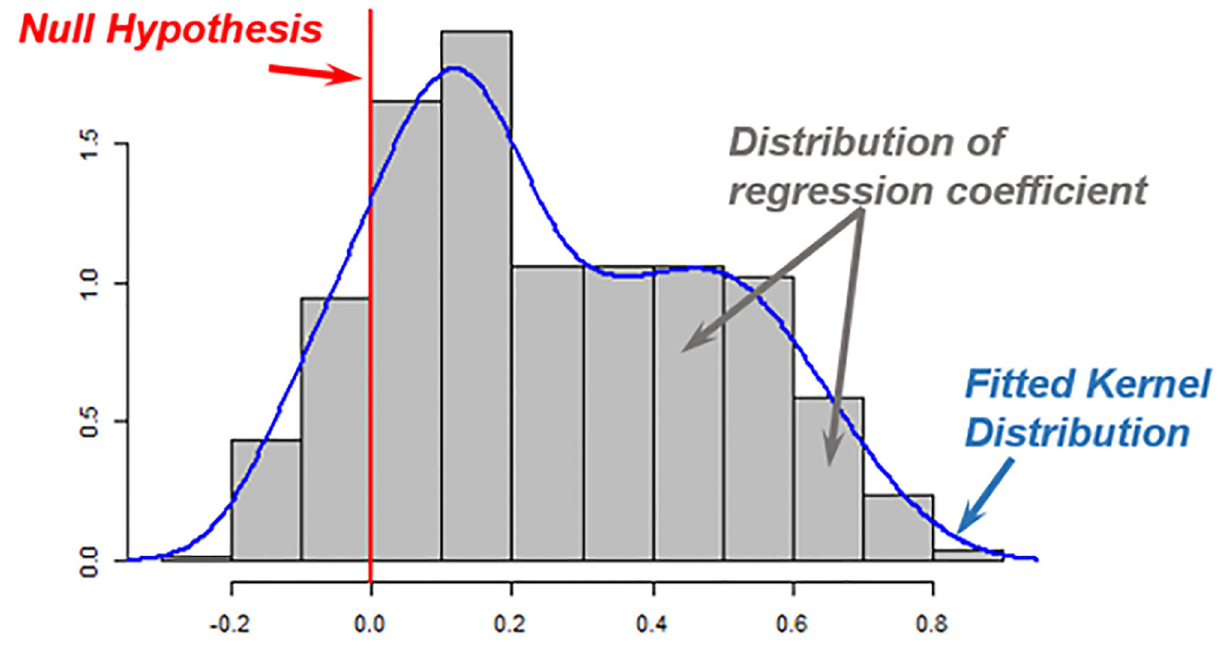
Fig 2. Illustration of EBA null